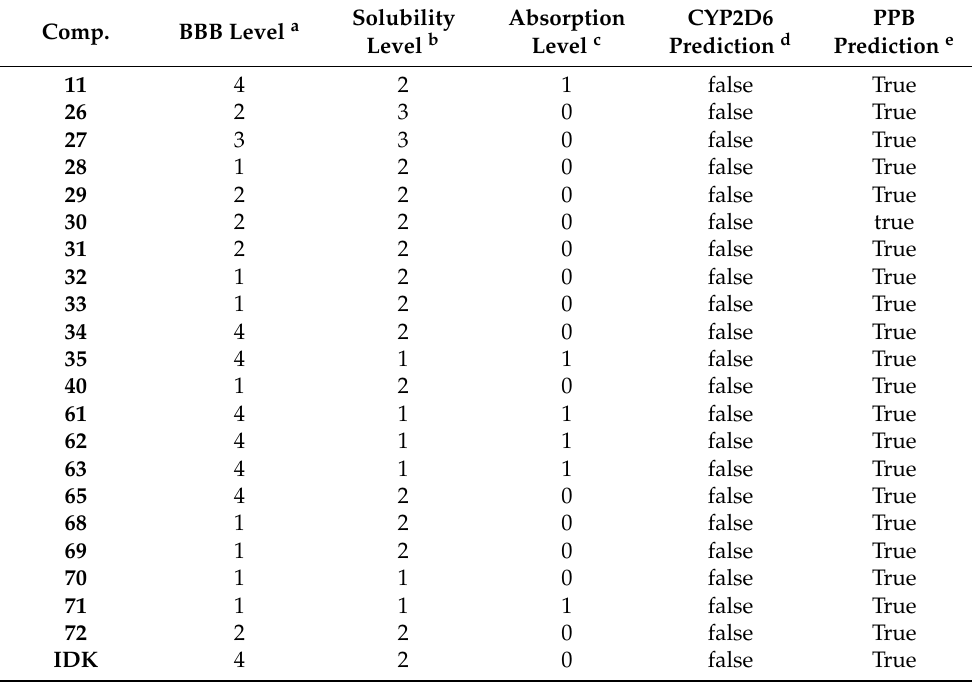
Table 2. Predicted computational ADMET for the tested candidate. Comp. BBB Level a